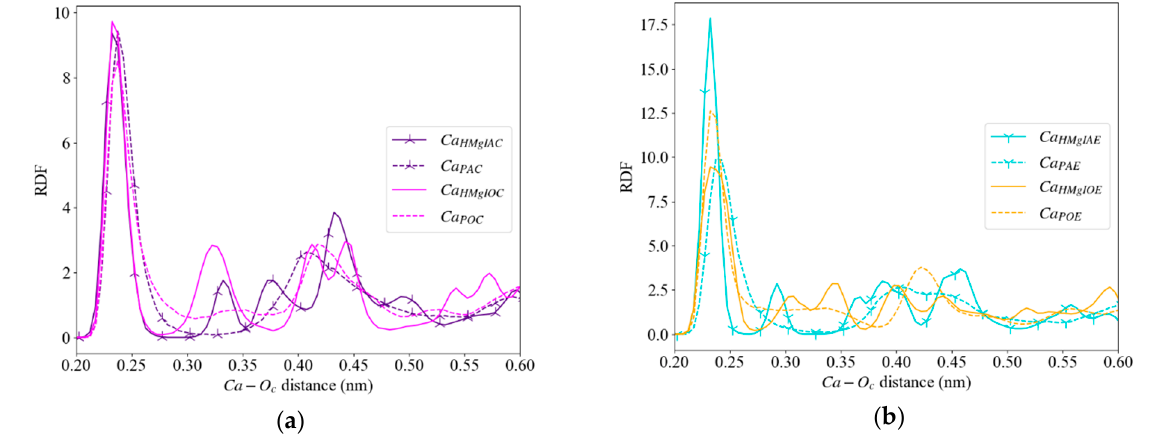
Figure 7. Radial distribution function (RDF) of the different calcium ions with O c . ( a ) The acute and obtuse calcium corners and ( b ) the acute (with tripod marker) and obtuse calcium edges of the pure (dashed line) and HMg (continuous line) with the corresponding colours as presented in Figure 6.